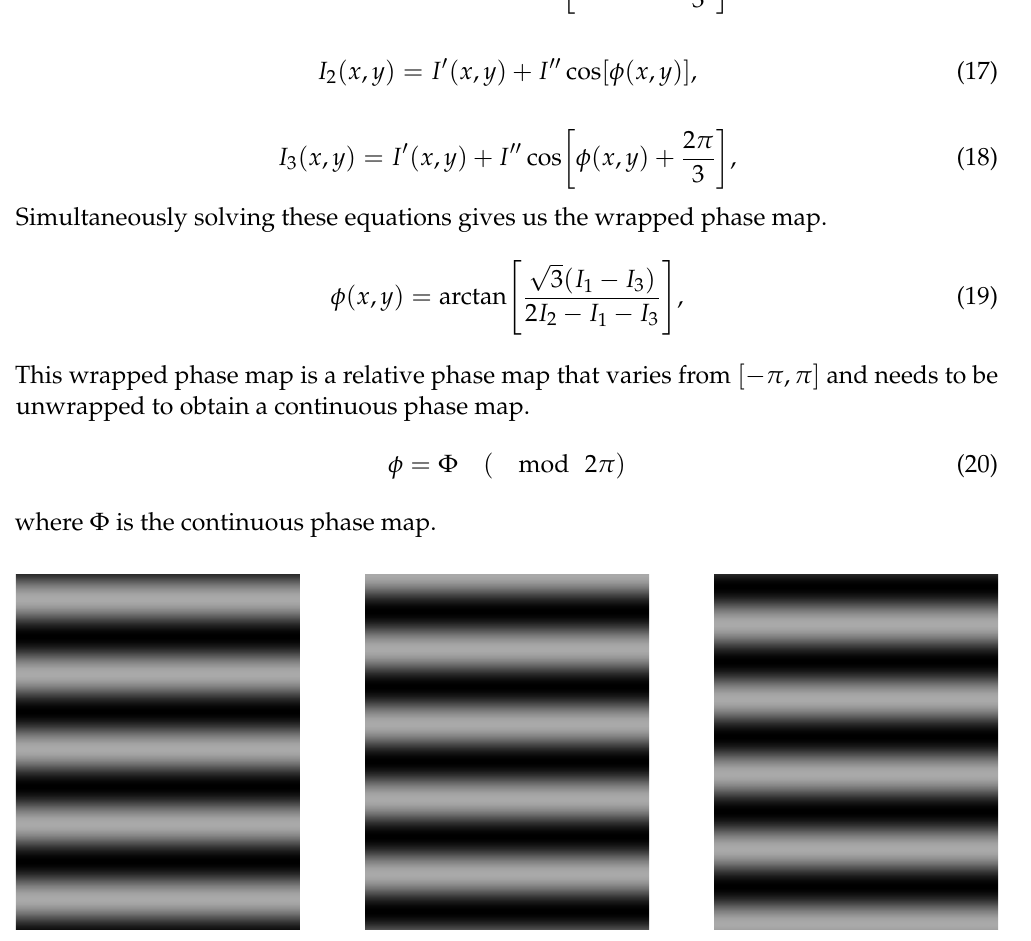
Figure 6. Example Sinusoidal Phase Shifted Fringe